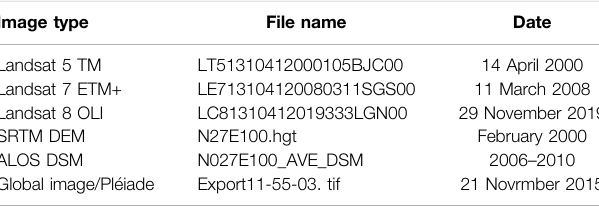
TABLE 1 | Image type, fi le name, and acquisition date of the remote sensing images used in this study. Image